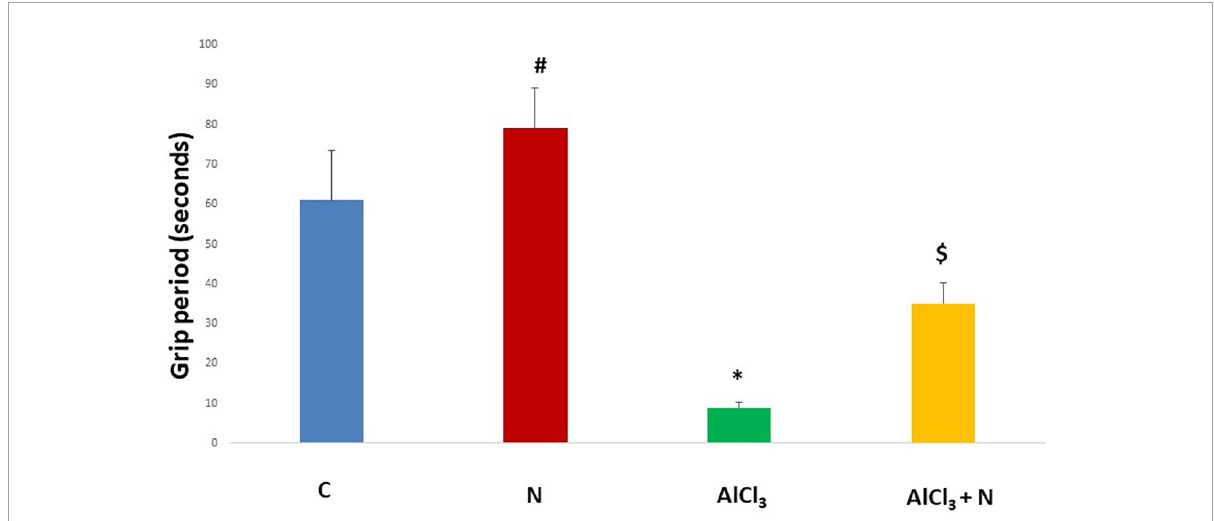
FIGURE3 Grip period in the Rotarod test in the studied groups. n = 6 in each group. Data were prescribed as mean ± SD . The intergroup variation was conducted by Games-Howell post-hoc test. ∗ p < 0.001 compared with C group. # p < 0.001 compared with AlCl 3 . $ p = 0.01 compared with AlCl 3